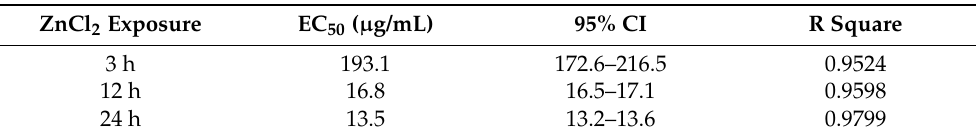
Table 2. Exposure of human keratinocyte HaCaT cells to ZnCl 2 for 3, 12 and 24 h. Median effective concentration (EC 50 ), confidence limits 95% (CI) as mass/volume in µ g/mL and R square. ZnCl 2